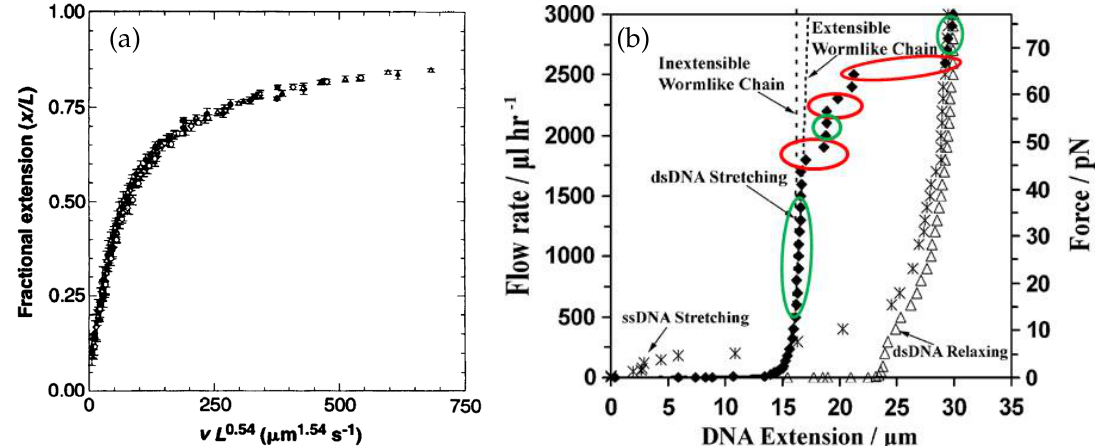
Figure 5. (a) Variation of the fractional extension of a DNA molecule with the similarity parameter vL 0.54 , obtained from the experiments by Perkins et al. [24]. (b) Force-extension curves for single and double-stranded DNA molecules, obtained from the experiments by Wang and Lu [77]. The stretching transitions and plateaus are marked with red and green ellipses, respectively.